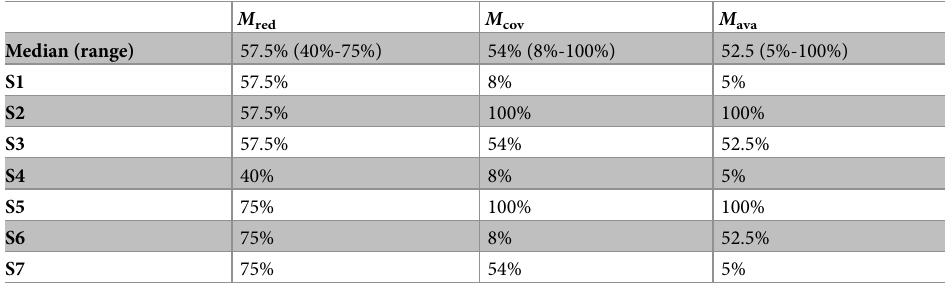
Table 2. Parameters for reproduction number, infection attack rate, and infected cases in seven scenarios (S1 to S7). M red M cov M ava Median